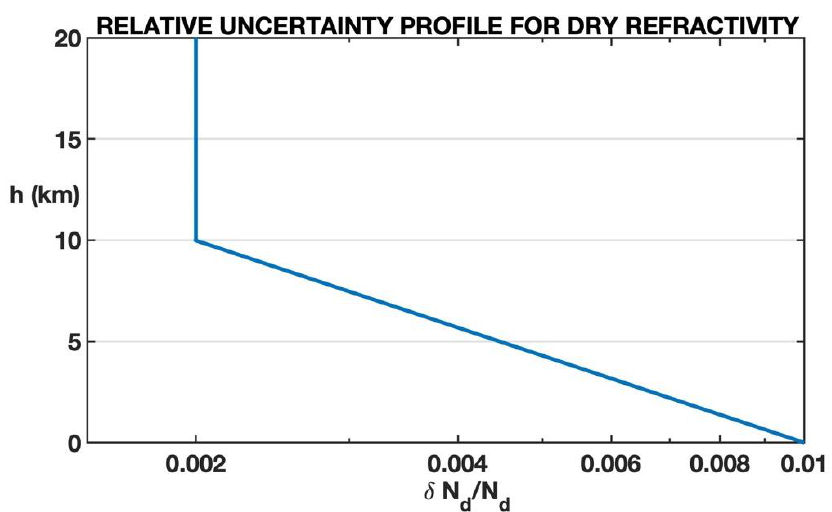
Figure 5. Graphical representation of the RO uncertainty profile 2., deduced from Figure 13 of [15].